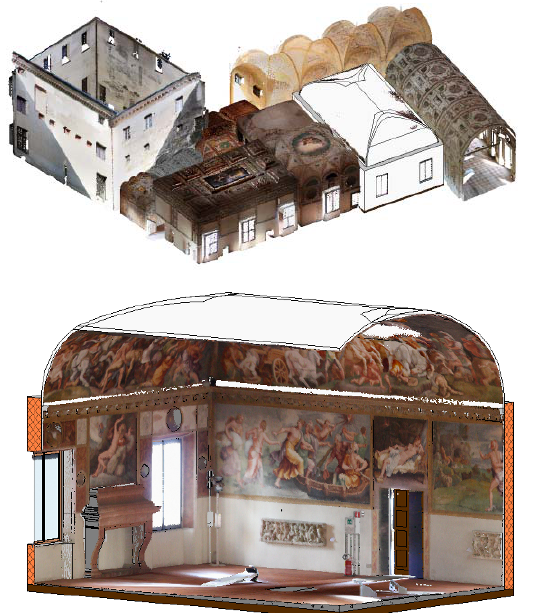
Figure 1: (top) the 3D model of Sala di Troia with all the point clouds of Apartment di Troia, (bottom) point cloud integrated in Revit